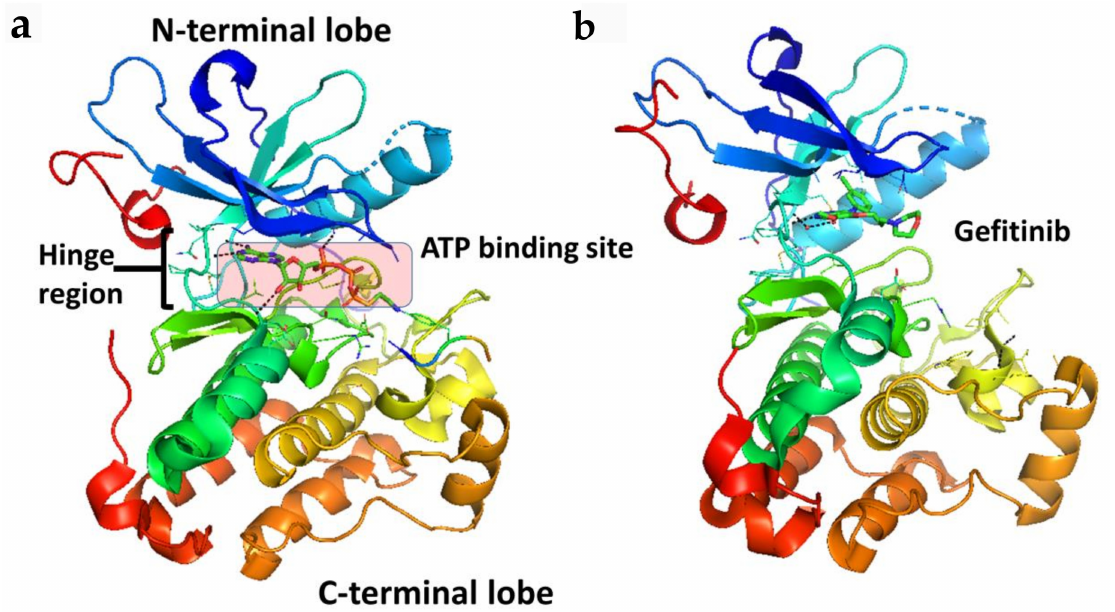
Figure 2. Crystal structure of the kinase domain of EGFR ( a ) with ATP binding site highlighted (PDB ID: 2GS6). TKIs of EGFR bind to EGFR in the ATP binding pocket, forming 1 to 3 hydrogen bonds to the hinge region. ( b ) EGFR kinase domain with gefitinib bound in the ATP binding pocket (PDB ID: 3UG2). PyMol (Schrodinger LLC. OR, New York, NY, USA) was used to generate the figure